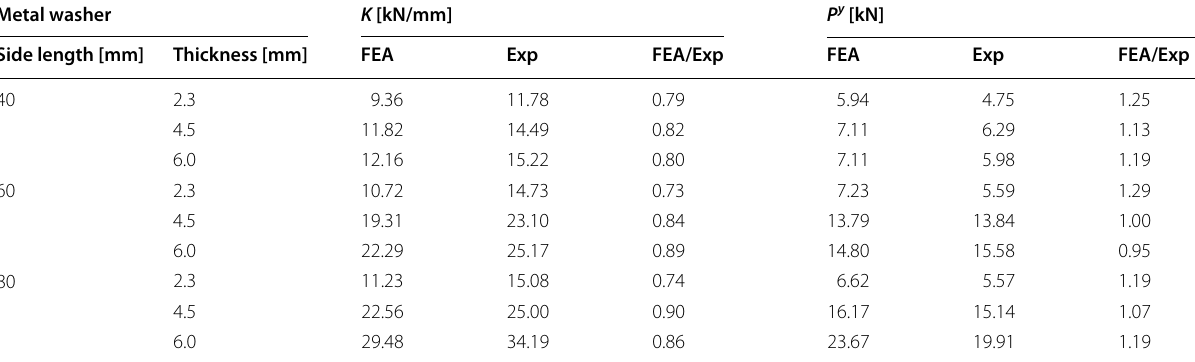
Table 4 Initial stiffness and yield load obtained via experiment and FEA Metal washer K [kN/mm] P y [kN] Side length [mm] Thickness [mm] FEA Exp FEA/Exp